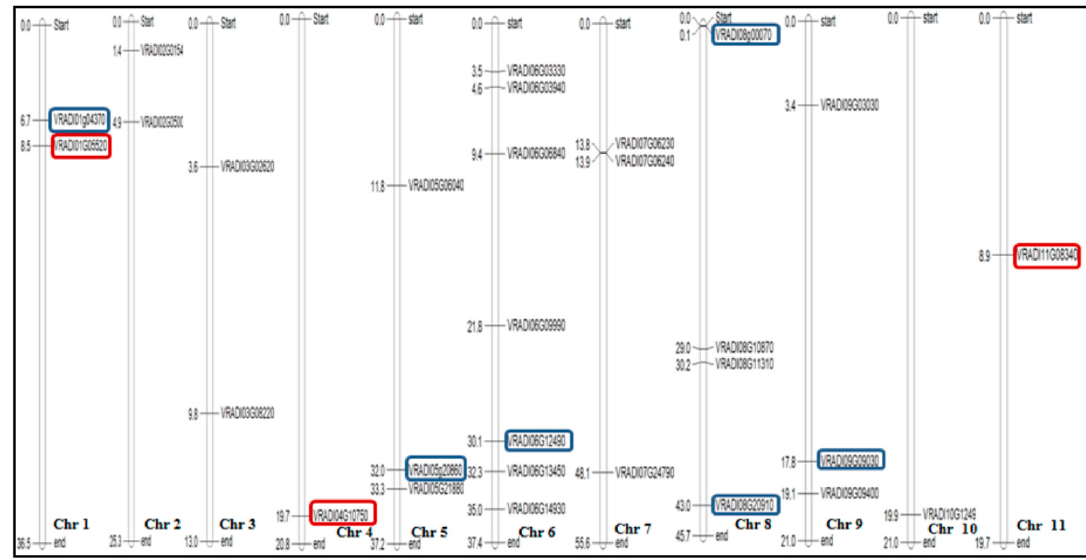
Figure 8. Chromosomal location of identified